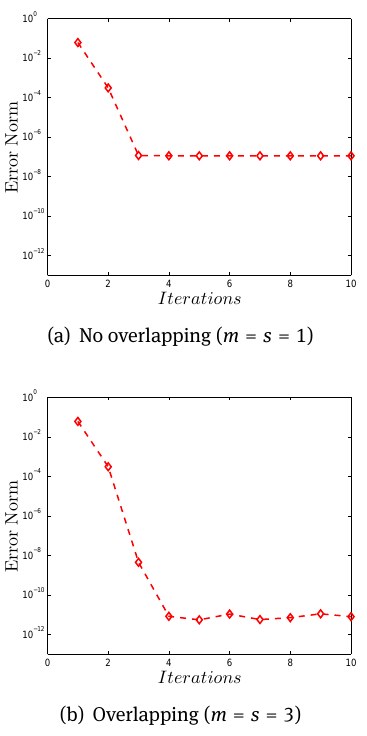
Figure 15: Convergence graphs for example 4 when t = 2, k = 1, p = 2, and N = N = x t